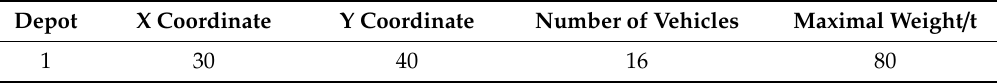
Table 8. Position of the depot and information about vehicles.